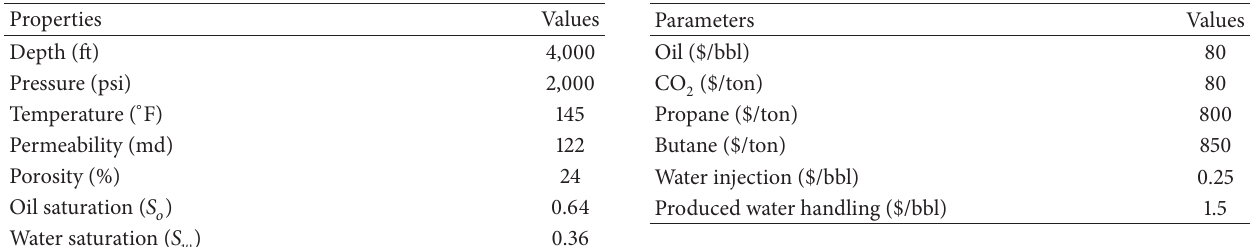
Table 4: Properties of reservoir rock and fluids.